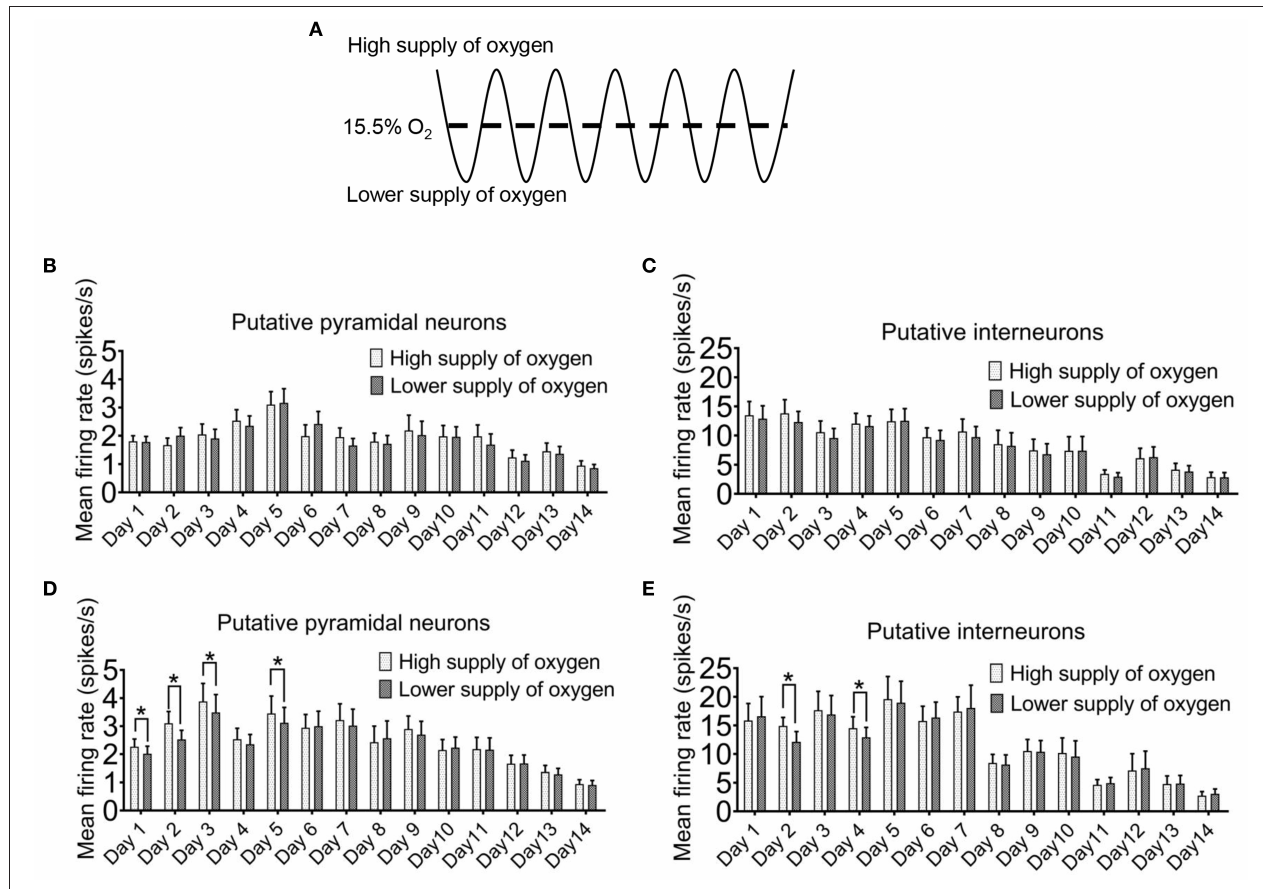
FIGURE 4 | Instantaneous firing of hippocampal neurons can be affected by the ambient oxygen level in the hypoxic cycle. (A) The time period during which the ambient O 2 level was above the mean (15.5%) was regarded as high supply of O 2 , while the time period during which the O 2 was below the mean was designated as lower supply of O 2. In the first 5min of intermittent hypoxia (IH), the level of oxygen supply had no clear effect on the firing of both the putative pyramidal neurons (B) and the putative interneurons (C) . However, in the last 5min of 8h IH treatment, both putative pyramidal neurons (D) and putative interneurons (E) tended to fire more during the period of higher oxygen supply. The data were from 50 putative pyramidal neurons and 12 putative interneurons (six rats). Wilcoxon’s paired signed rank test for pyramidal neurons; Paired Student’s t -test for interneurons; * P < 0.05.